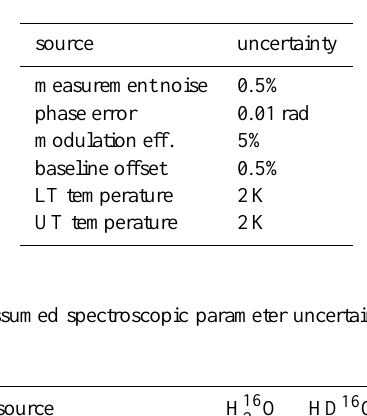
Table 2. Smoothing error of the column integrated values for the retrievals in the different spectral regions.